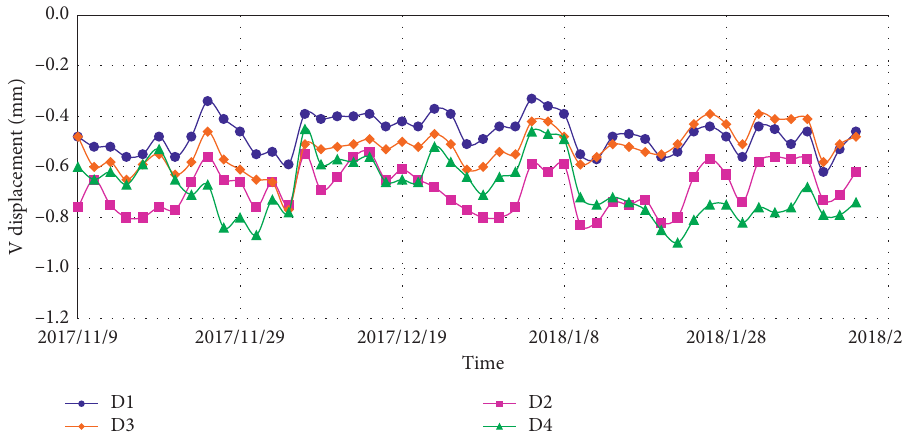
Figure 18: Plot of beam end displacement versus time during the process of bearing capacity